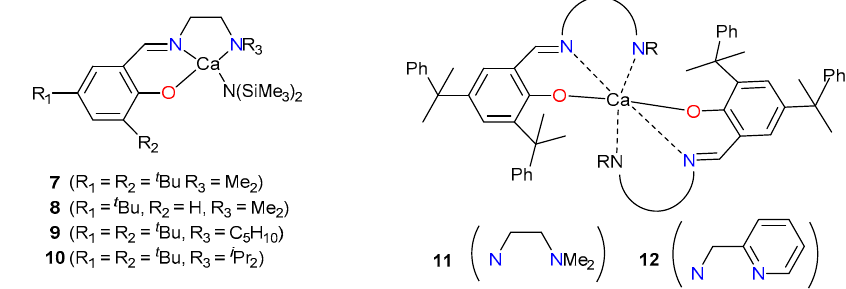
Figure 2. Calcium complexes bearing tridentate Schiff-base ligands [36–38]. Table 2. ROP of ε -CL and r -LA catalyzed by 7 , 9 and 10 [37]